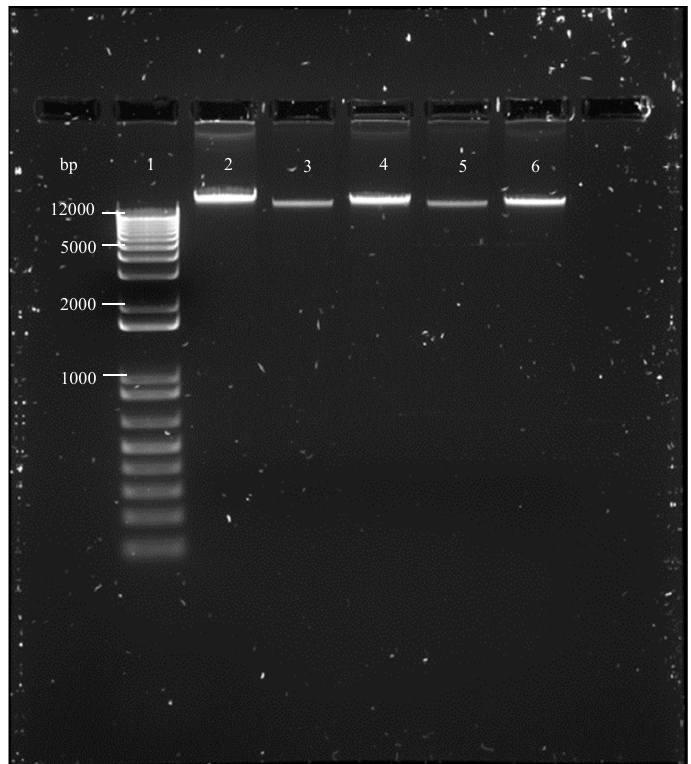
Figure 4. Analysis of DNA fragmentation in 1 - and 2 -treated T. b. rhodesiense for 72 h. Agarose gel represent the results of a typical experiment that produced similar results. Genomic DNA (10 μ g/lane) from treated and untreated trypanosomes was resolved on a 1.2% agarose gel for 40 min at 70 V, then visualized under UV light. Lane 1, size marker 1 kb DNA ladder; lane 2, untreated trypanosomes; lane 3 and 4, DNA from trypanosomes treated with 0.41 and 0.83 μ M of 1 ; lane 5 and 6, DNA from trypanosomes treated with 0.71 and 1.21 μ M of 2 . bp, base pair.